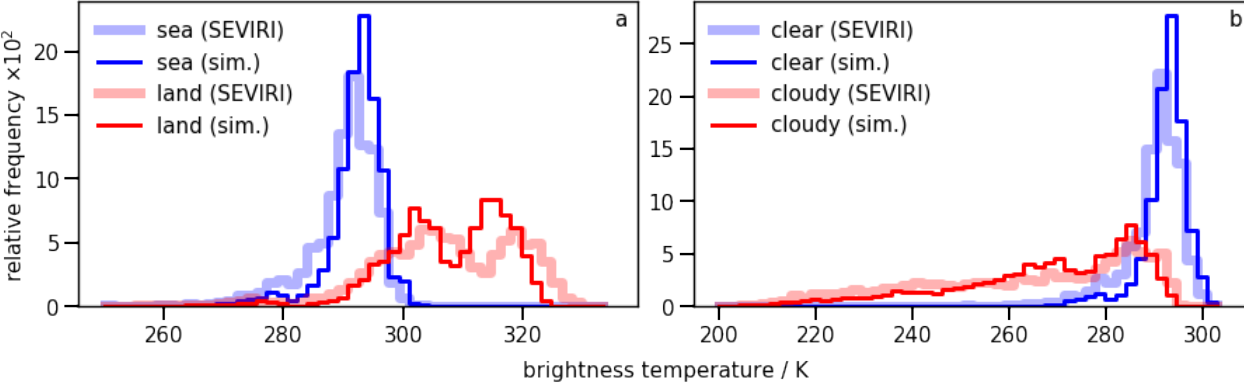
Figure 11. Distributions of BT 10.8 as measured by MSG/SEVIRI and as simulated using RTSIM and libRadtran: ( a ) sea and land surfaces for clear sky conditions; ( b ) sea surfaces for clear and cloudy